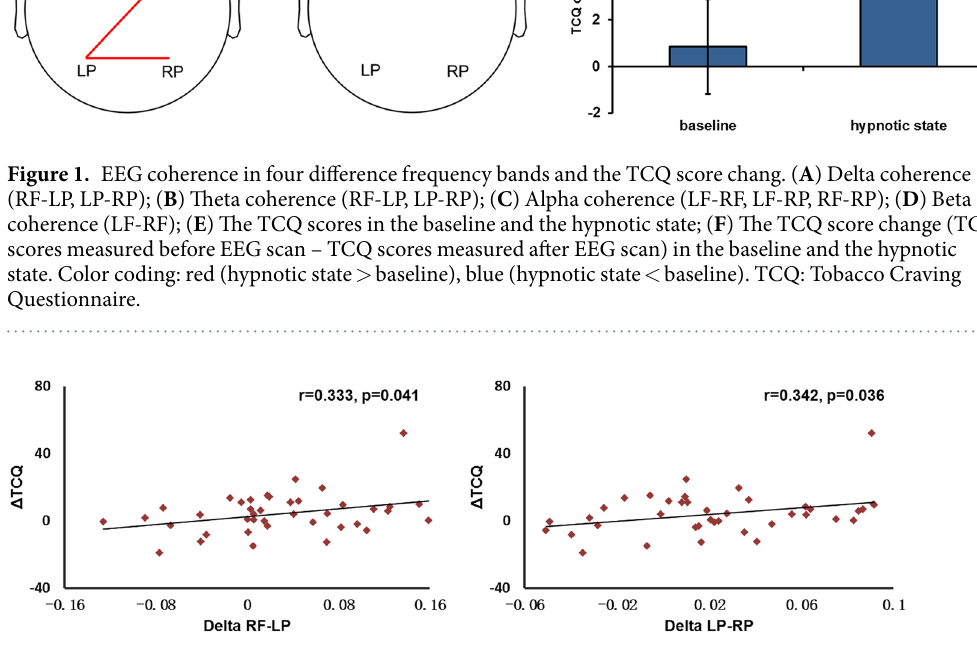
Figure 2. Delta coherence changes were correlated with TCQ change between states. ( A ) Delta coherence in the RF-LP; ( B ) Delta coherence in the